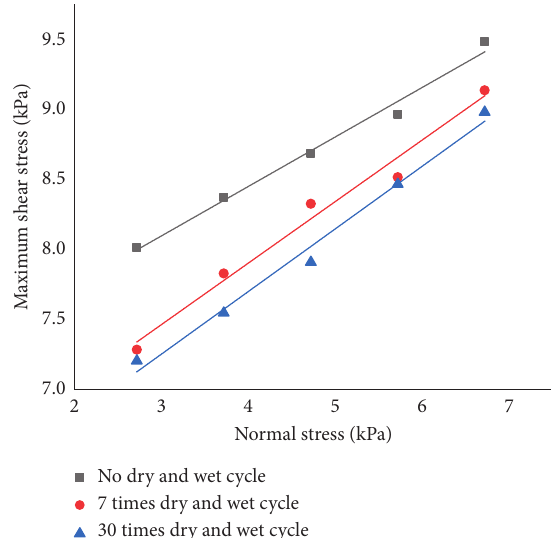
Figure 12: The maximum shear stress-normal stress curve for different dry-wet cycles with water content of 14%. 1.21.41.61.82.02.22.42.62.83.0